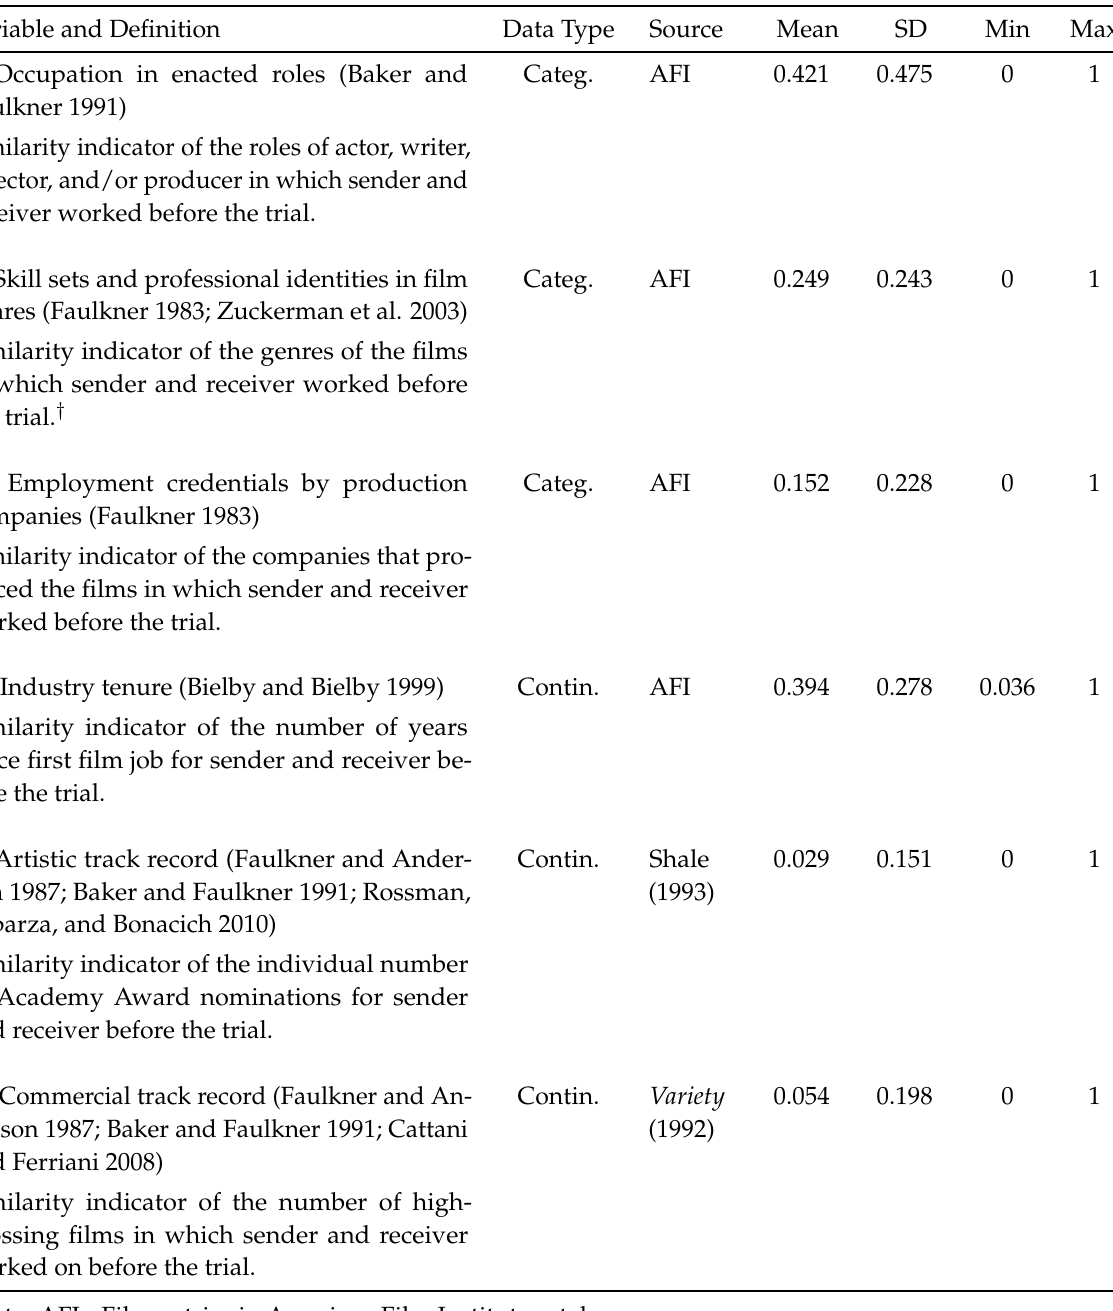
Table 1: The Variables of Niche Overlap Variable and